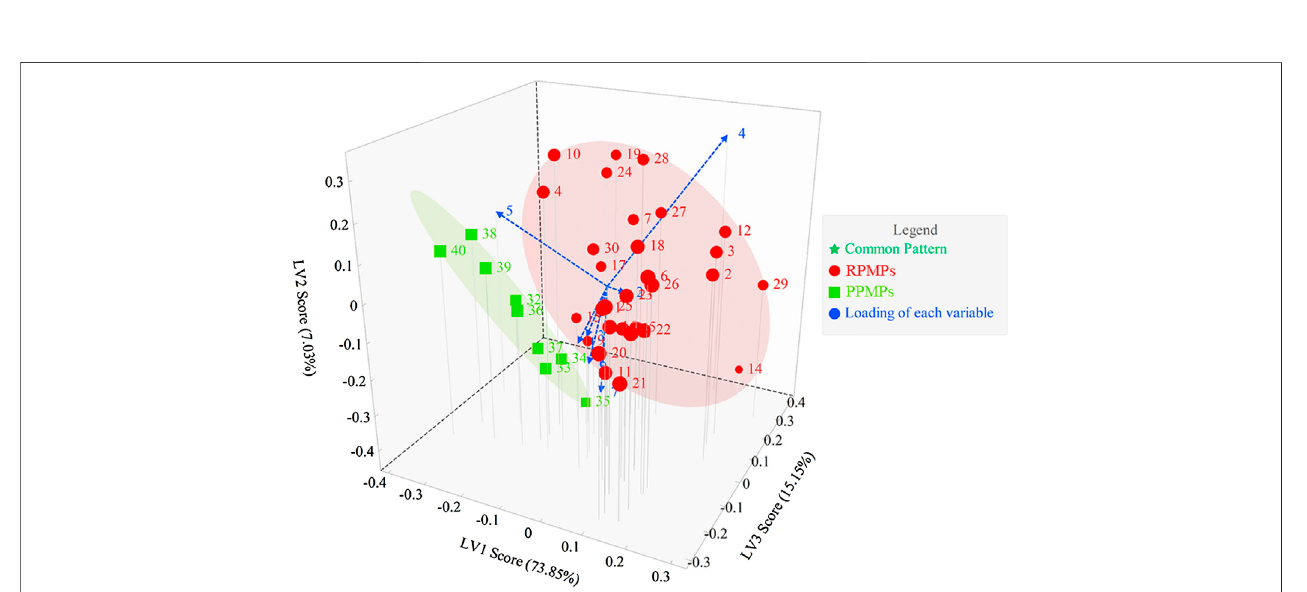
FIGURE 5 | The score plot and loading plot of PLS-DA from PCD-UPLC fi ngerprints.